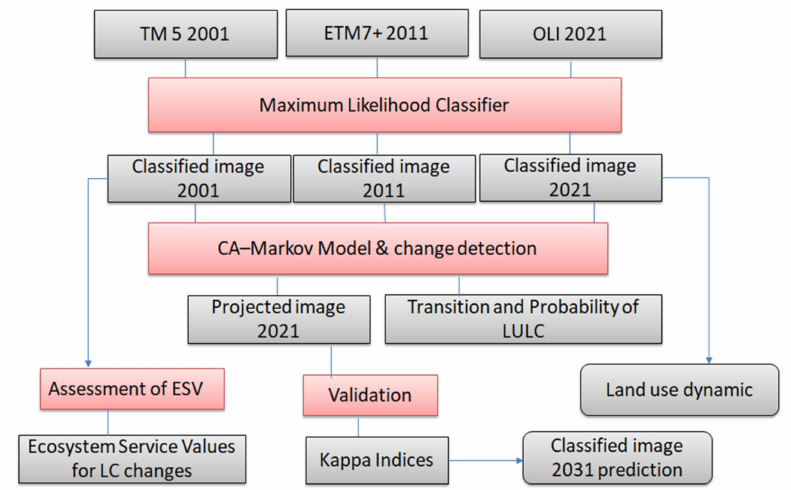
Figure 2. Flow chart illustrates methods of LULC and ESV